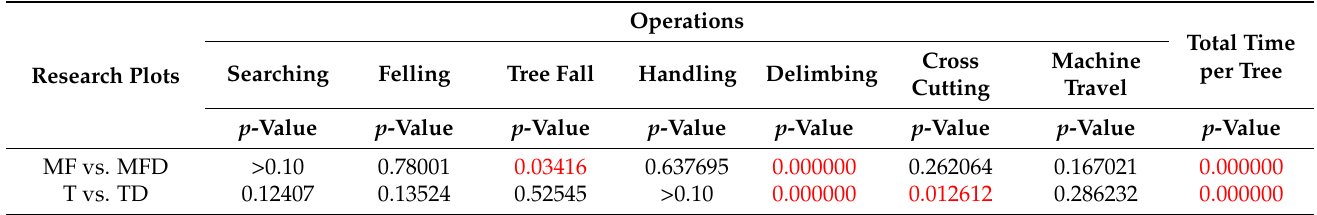
Table 3. Results of the statistical analysis of the time study.